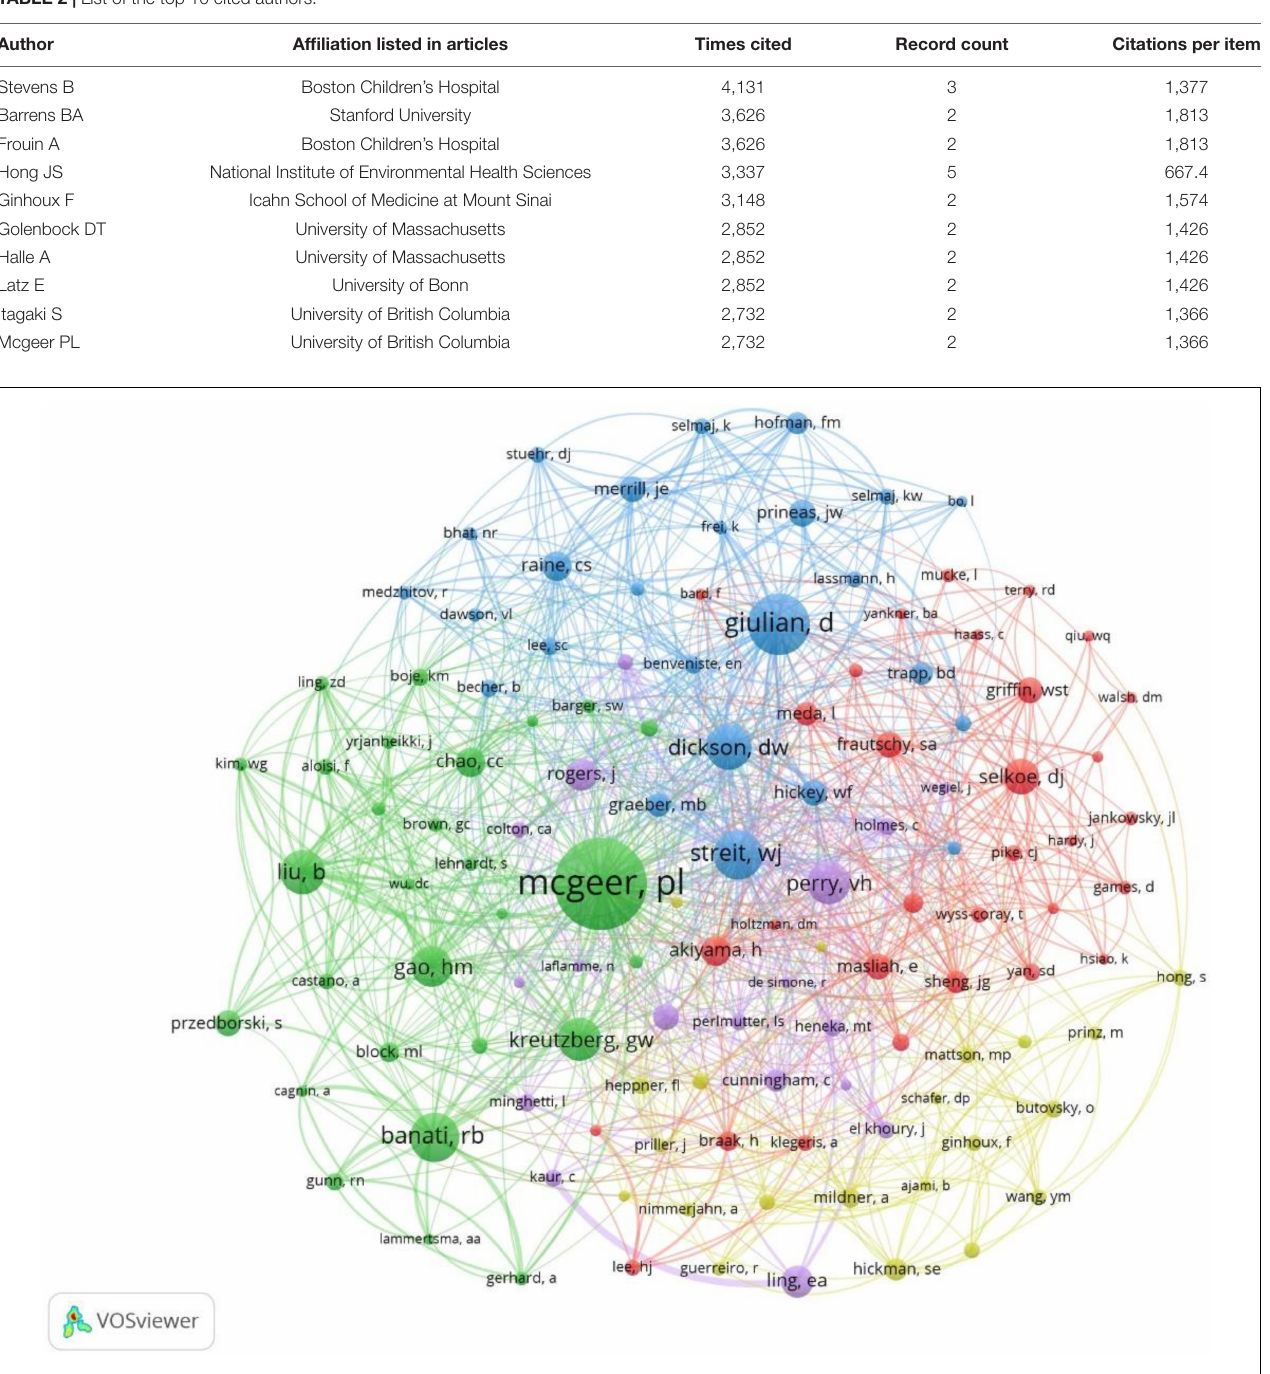
TABLE 2 | List of the top 10 cited authors.